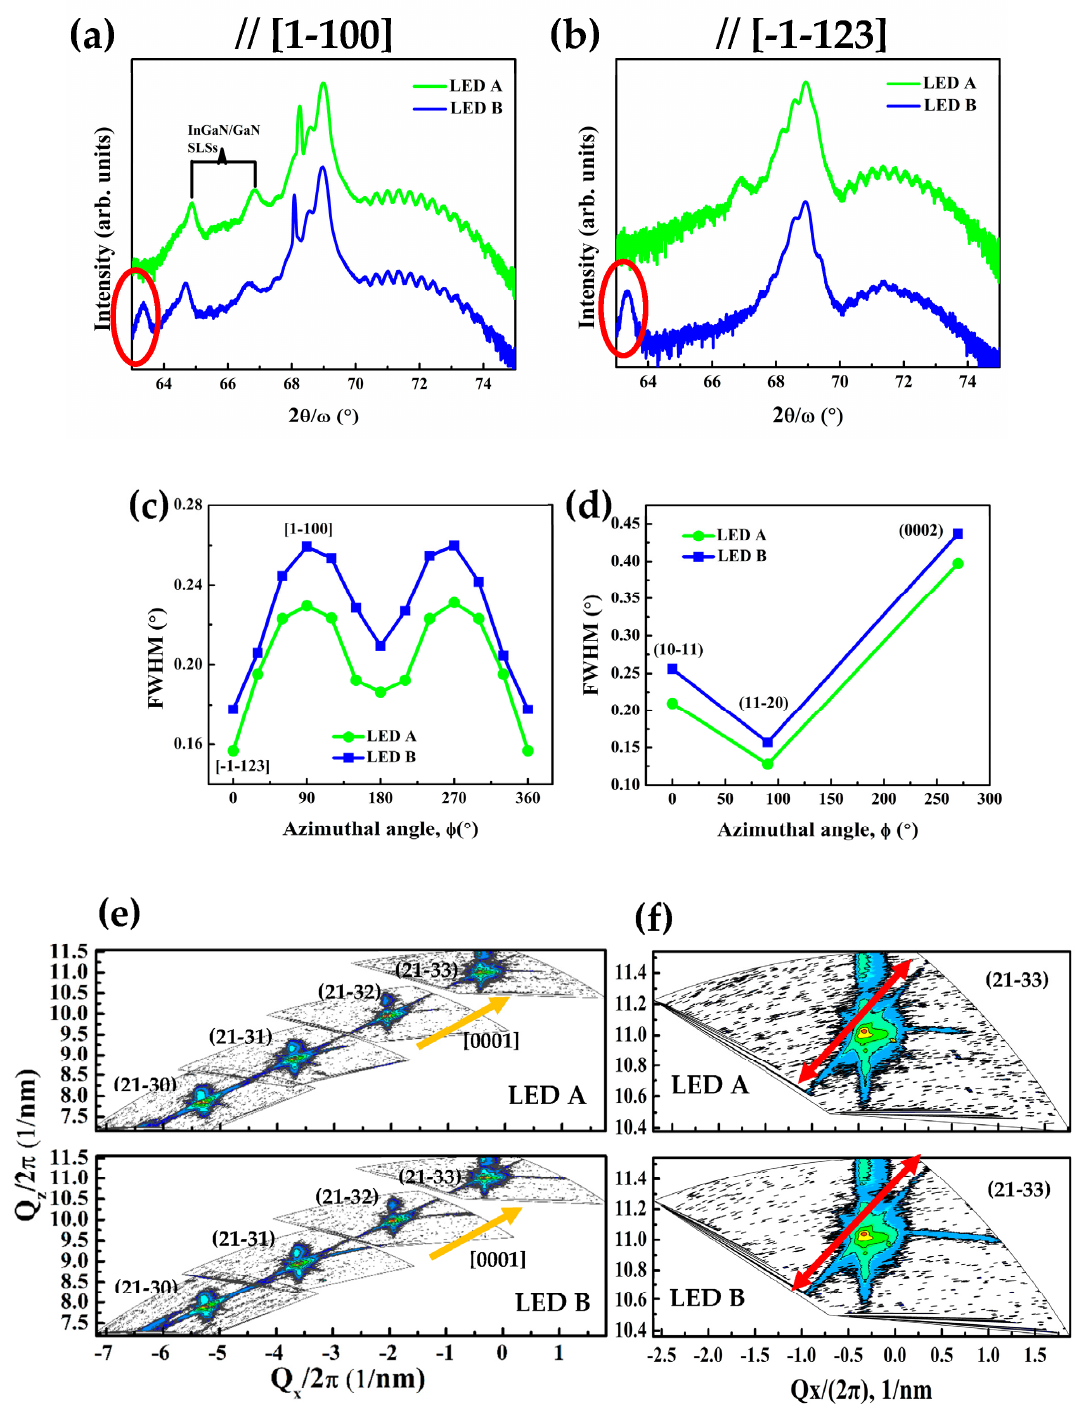
Figure 3. ( a , b ) 2 θ / ω scan for sample LED A and B along [1–100] and [ − 1–123] direction, with red circle indicating the mixed phase (10–13) GaN; ( c ) On-axis rocking curve FWHM plotted as the function of azimuthal angle; ( d ) Off-axis rocking curve FWHM of the (10–11), (11–20) and (0002) plane plotted as the function of azimuthal angle, also the reciprocal space mapping (RSM) of ( e ) (21–3 l ) reflection ( l = 0, 1, 2 and 3) with orange arrow indicating the [0001] direction (BSF streak direction) and ( f ) (21–33) reflection with red arrow indicating the BSF streak length.